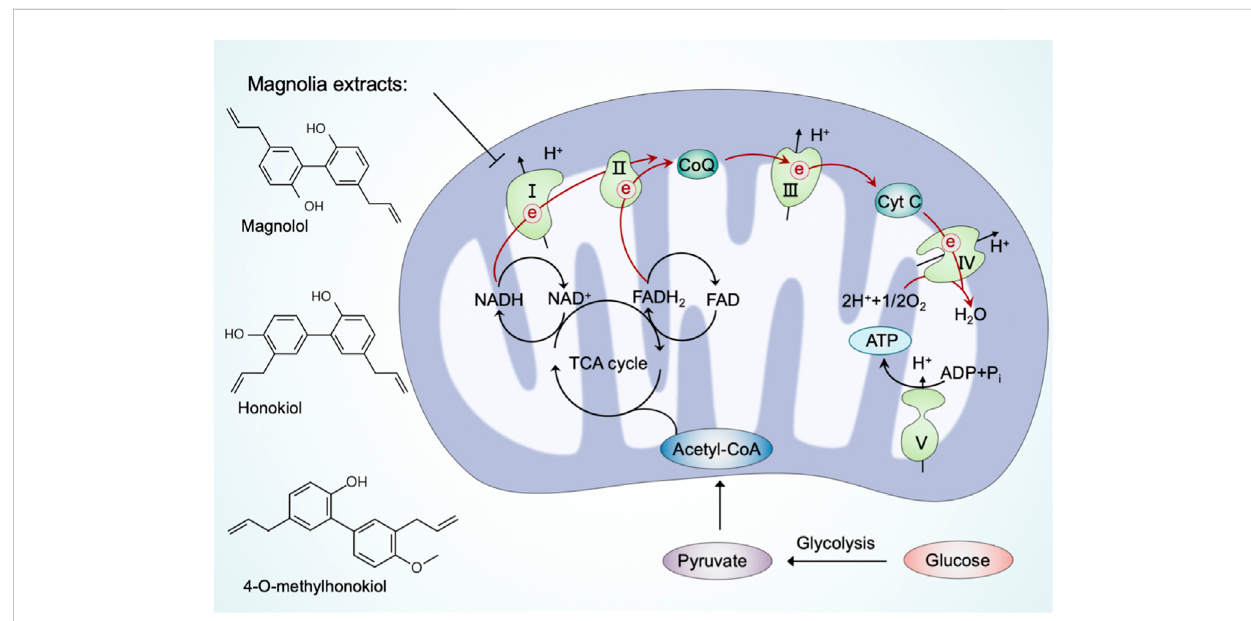
FIGURE 4 Natural products regulate mitochondria in cellular bioenergetics. Pyruvate, the end-product of glycolysis, is predominantly imported into mitochondria to form acetyl coenzyme A (acetyl-CoA) by the pyruvate dehydrogenase (PDH) complex. Acetyl-CoA fuels the TCA cycle to reduce NAD + andFADtoNADHandFADH 2 ,respectively,whichsubsequentlypowerupATPproductionthroughtheelectrontransportchain.Naturalproducts,suchas magnolia extracts, inhibit mitochondrial respiration at complex I to reduce cellular bioenergetics.